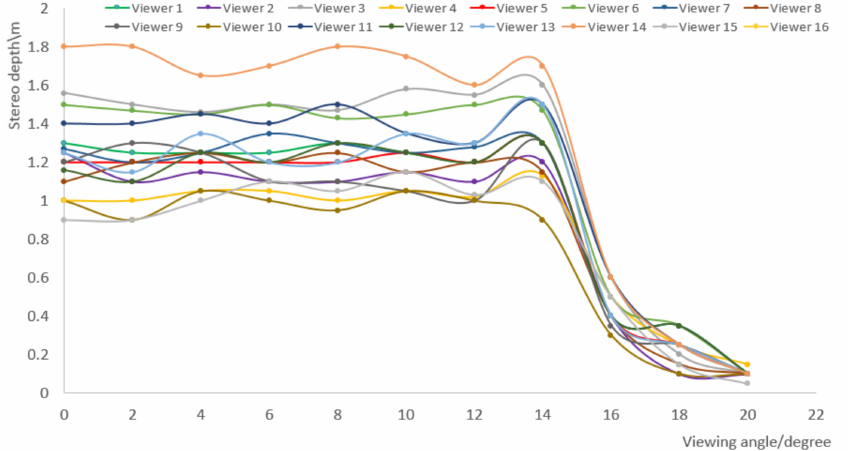
Figure 10. Perceived stereo depth of “lotus” on the prototype at different viewing angle by different